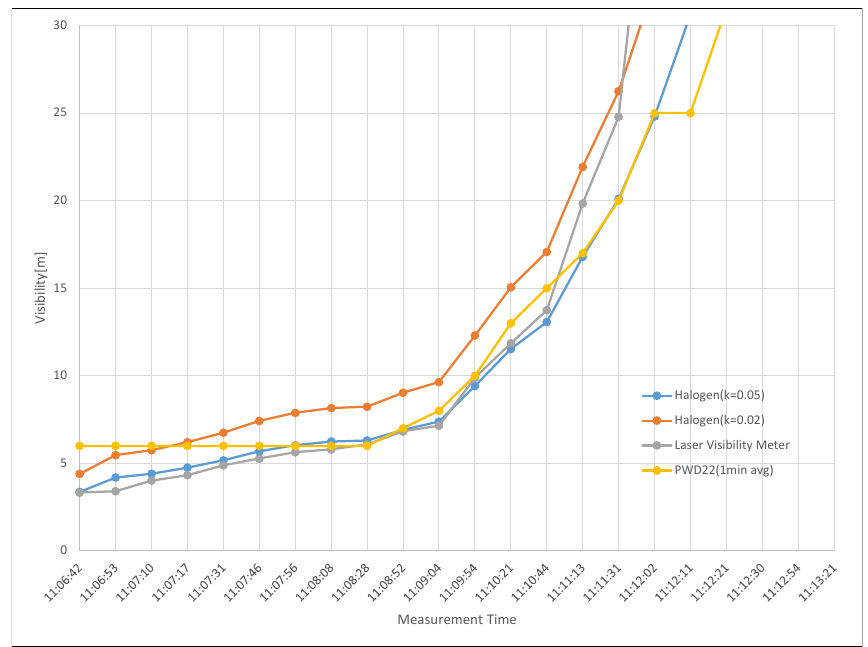
Figure 11. The visibility of the laser visibility meter, the visibility obtained from the forward scattering visibility meter (PWD22), and the visibility calculated using Equation(1) and the spectral transmittance obtained from the